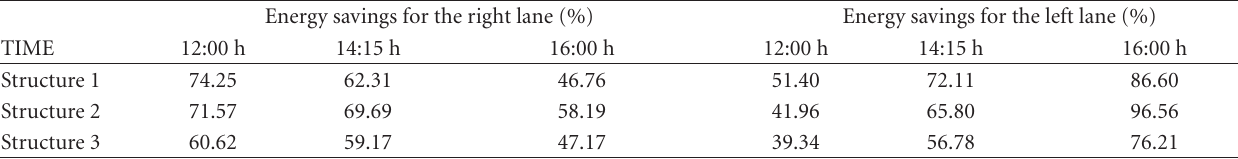
Table 3: Energy saving (%) for three tension structure shapes at the times tested. Energy savings for the right lane (%)